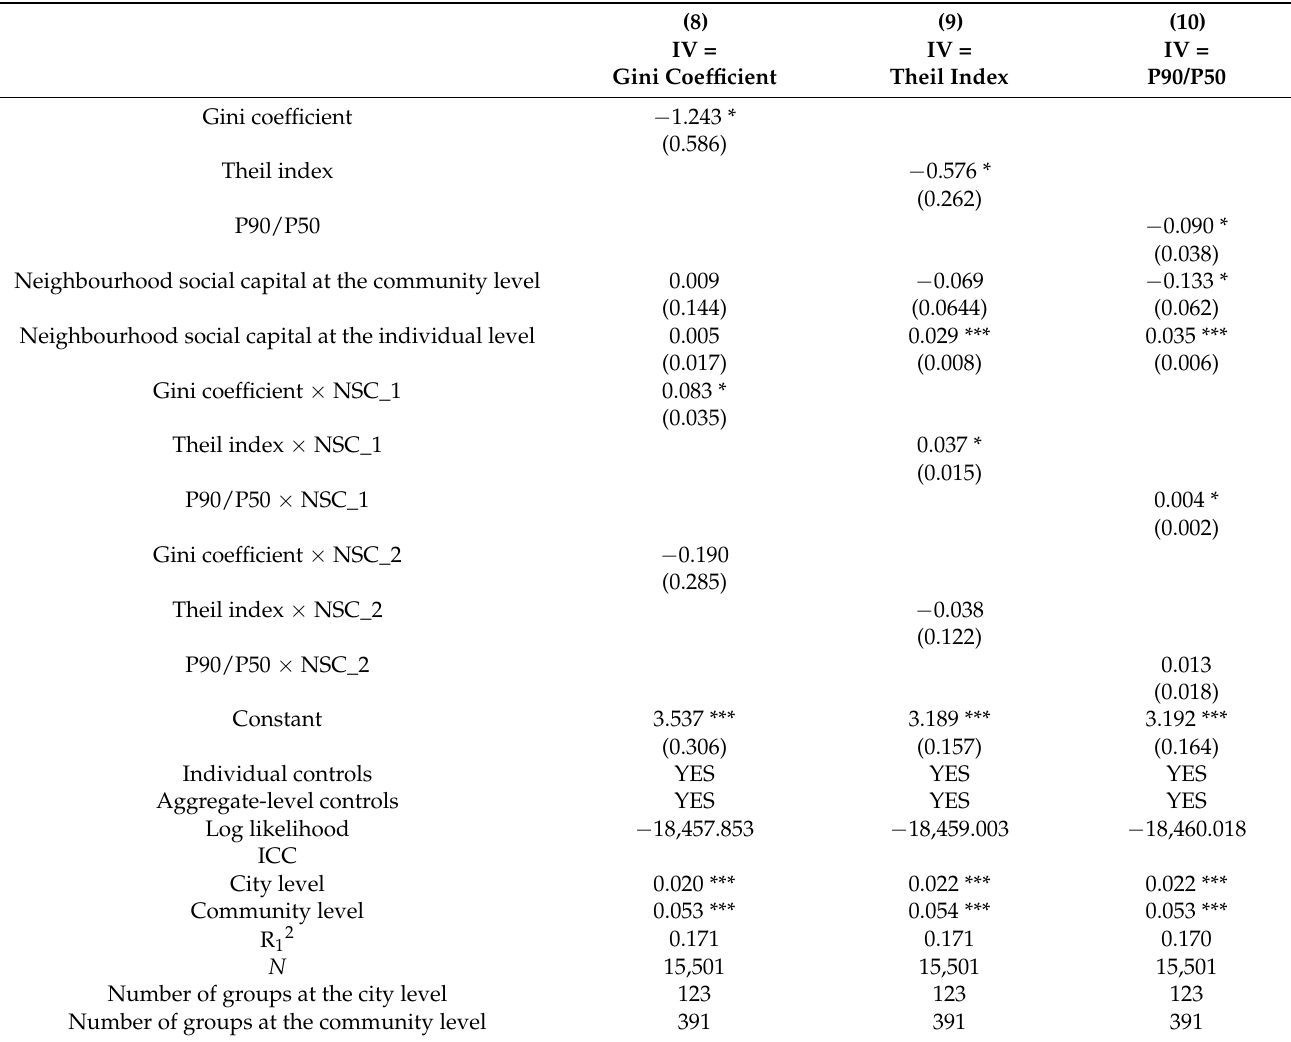
Table 5. Estimation results for the moderating effect of neighbourhood social